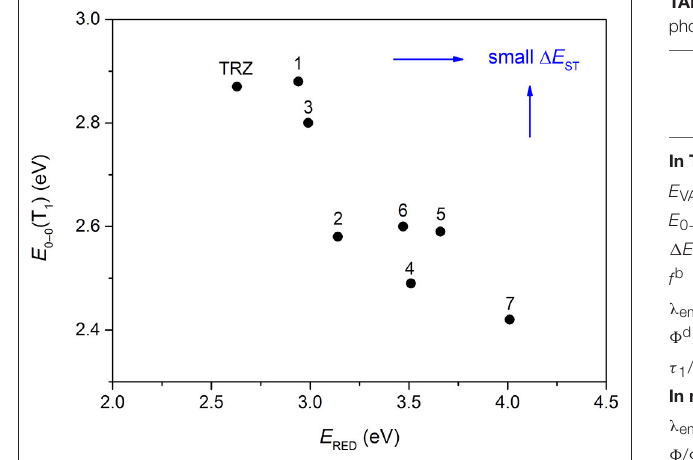
FIGURE 1 | Correlation of calculated E 0 − 0 (T 1 ) and E RED . The structures of the molecules are shown in Table 1 .